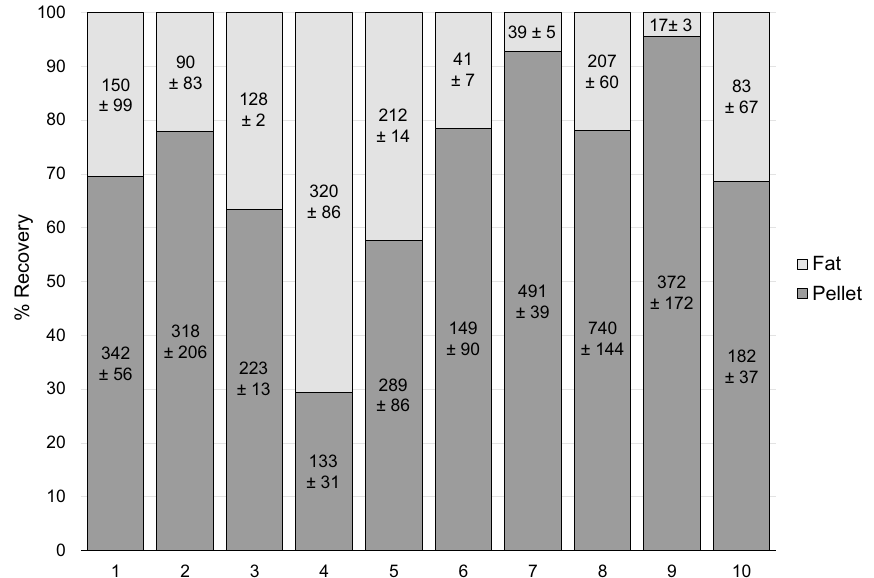
Figure 2. Percent recovery of spiked-in Staphylococcus aureus in different human milk fractions from ten samples (different to those used in the microbiome analysis). Percent recovery in supernatant not shown (< 0.03%). Data labels are × 10 4 CFU/ml ± standard deviation for